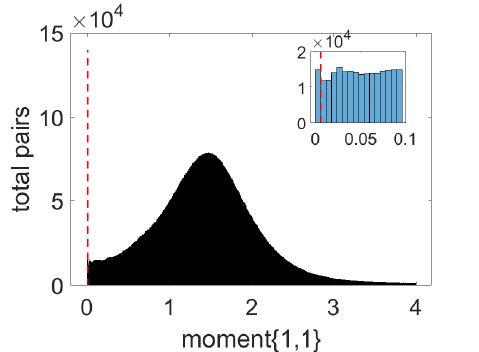
Figure 3. An example histogram plot for FPKM correlation